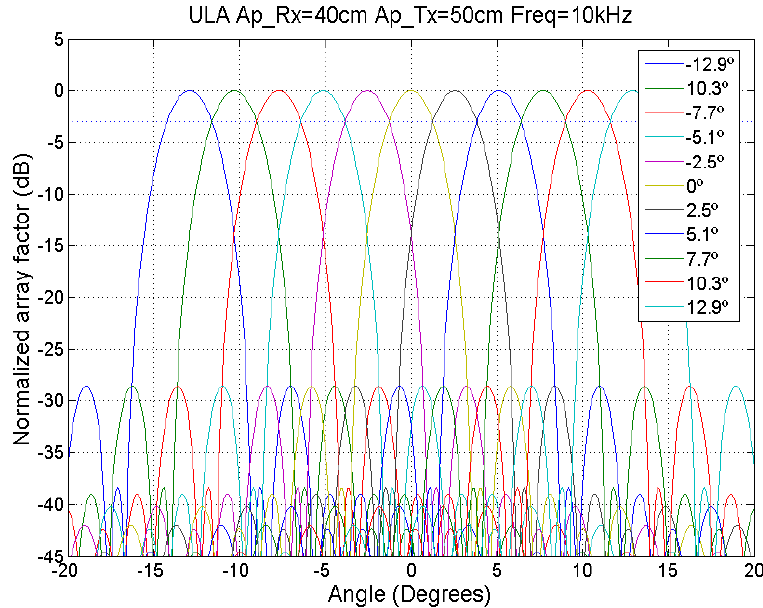
Figure 19. Collection of beampatterns to cover the exploration zone for f = 10